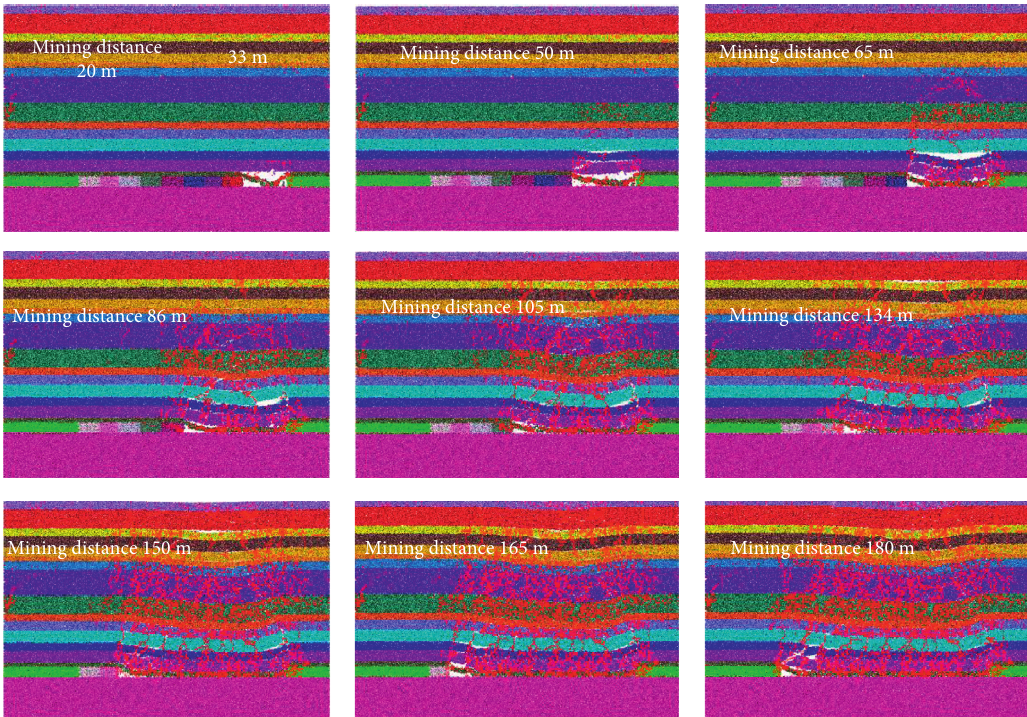
Figure 14: Caving characteristics of mining overlying rock of scheme